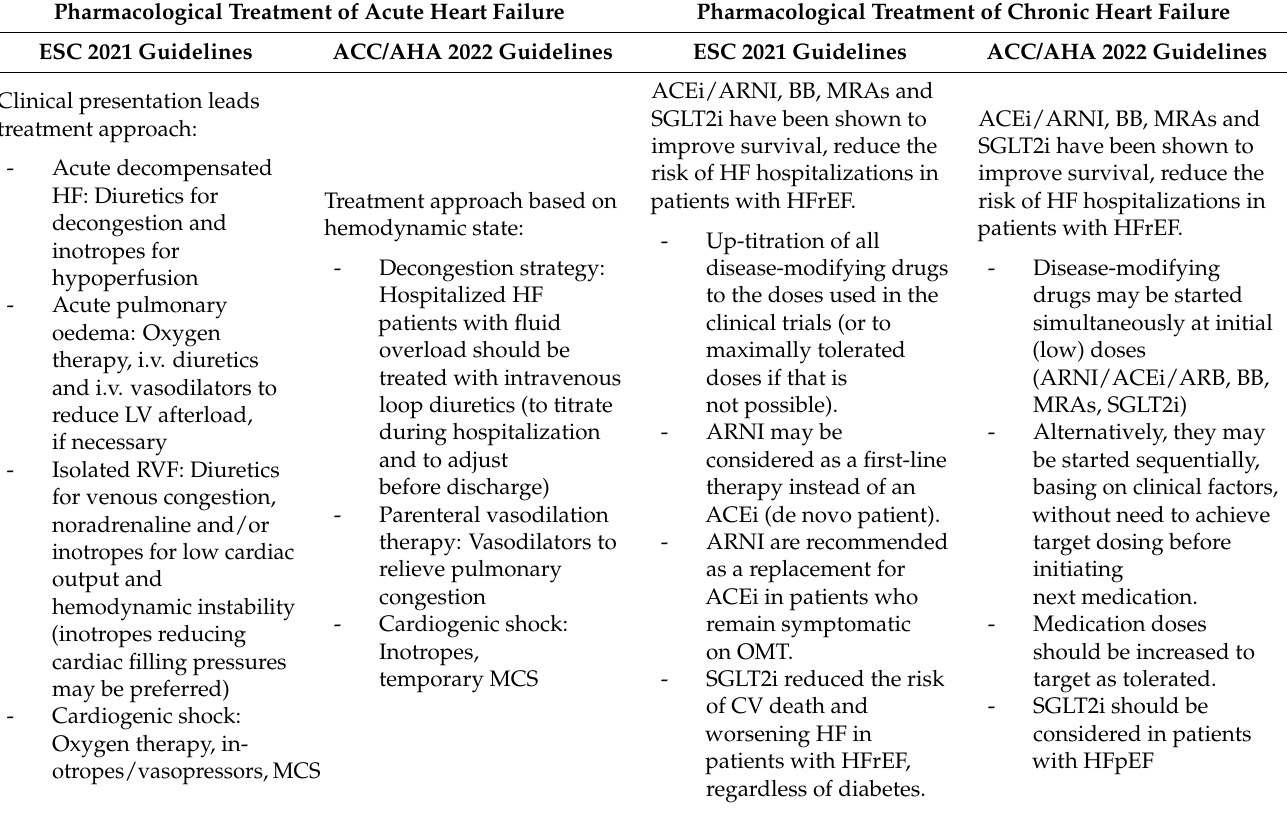
Table 1. Current evidences and indications reported by ESC and ACC/AHA Guidelines regarding the treatment of acute and chronic heart